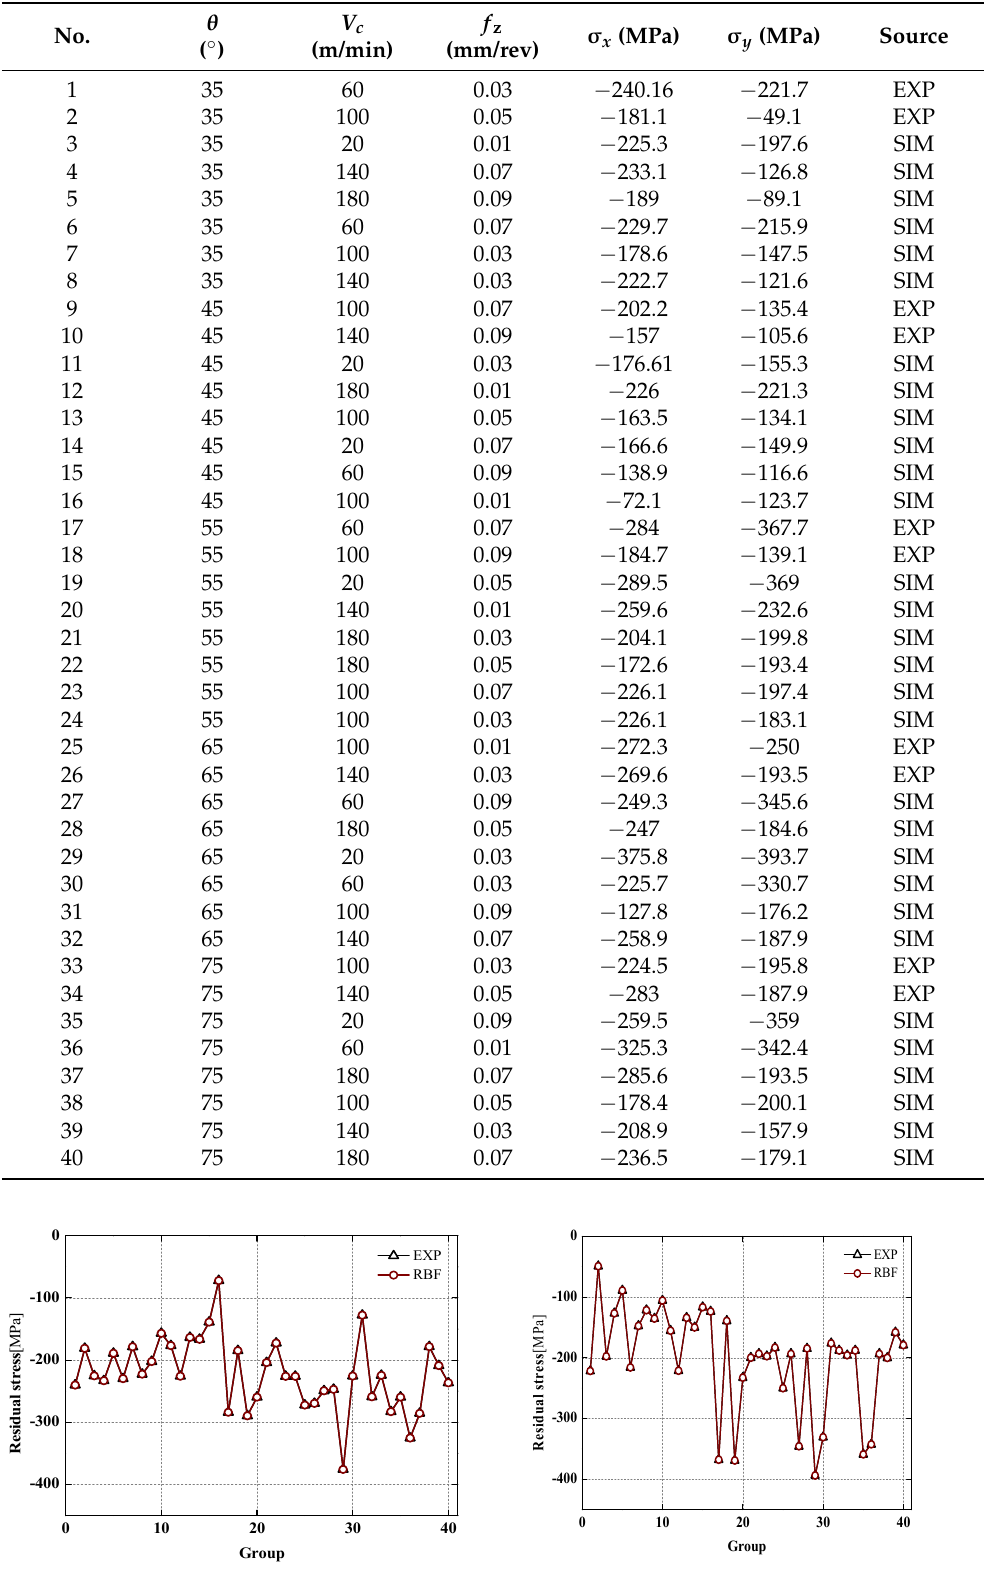
Table 5. Sample data of surface residual stress.